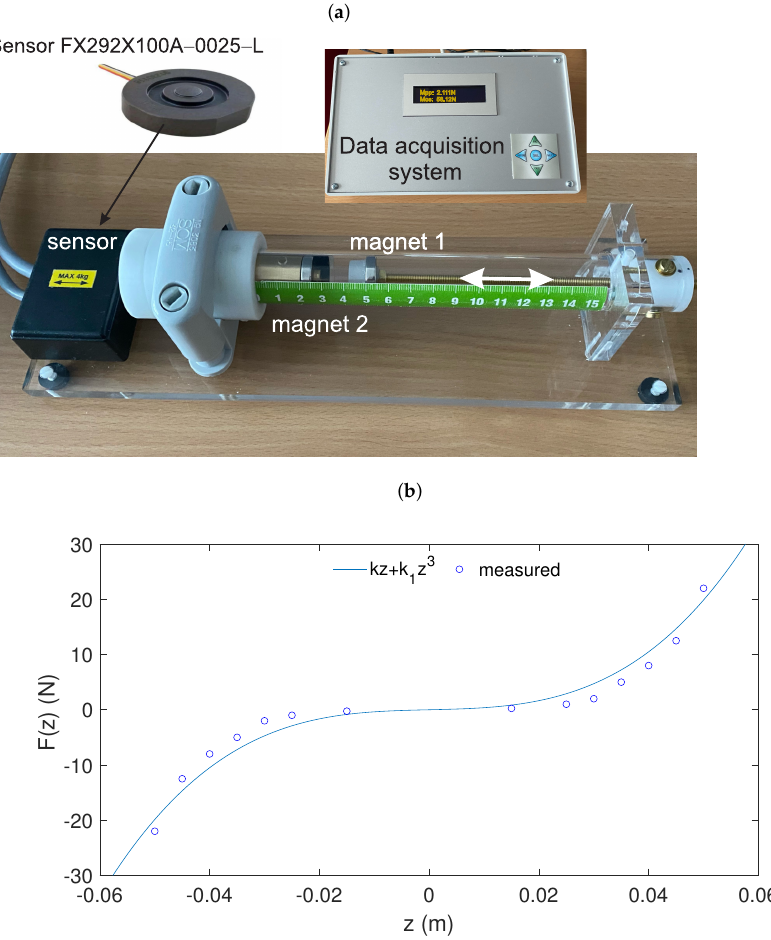
Figure 4. Photo of the magnetic force measurement setup ( a ) and a magnetic repulsion force vs. moving magnet displacement curve ( b